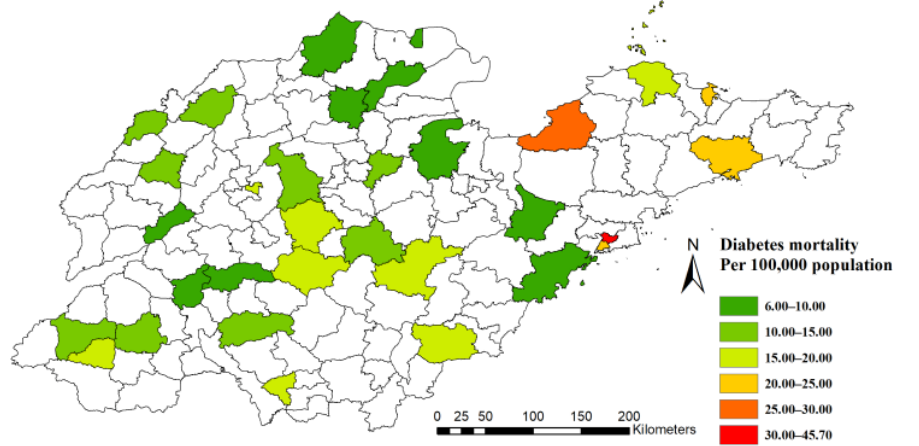
Figure 2. Diabetes mortality in 31 surveillance points in Shandong Province, China, 2014. Table 1. The distribution of diabetes death by gender, age and season in 31 death surveillance points in Shandong Province, China, 2014.